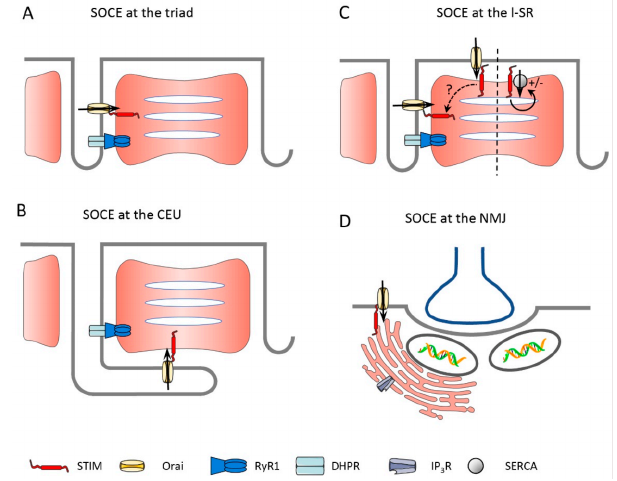
Figure 2. Schematic representation of possible sites of SOCE in skeletal muscle. ( A ) SOCE at the triad is well supported and the most described in the literature. STIM and Orai are expressed in the triad membranes and respective SOCE was confirmed. ( B ) SOCE at the CEU is well described as a newly formed structure that is induced by strenuous exercise. STIM and Orai are expressed at the CEUs but the respective SOCE Ca 2+ -flux has not yet been demonstrated to date. ( C ) STIM at the lSR moves to the triad upon activation or activates Orai at the PM. It was also reported to modulate the activity of the SERCA pump. ( D ) Localization at the NMJ remains speculative for the time